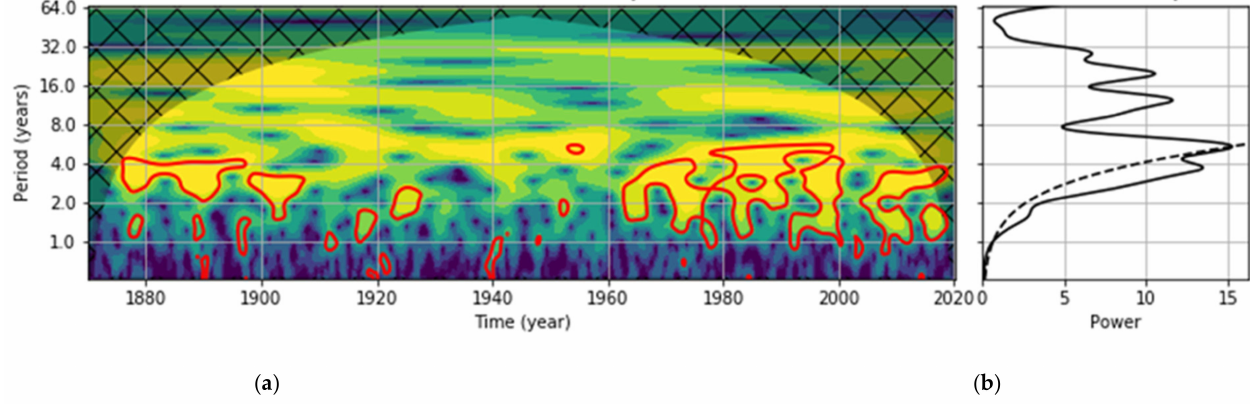
Figure 4. Illustration of quasi-periodicity (time between consecutive minima of La Niña episodes), based on Table S2. Numbers of episodes follow from this table.